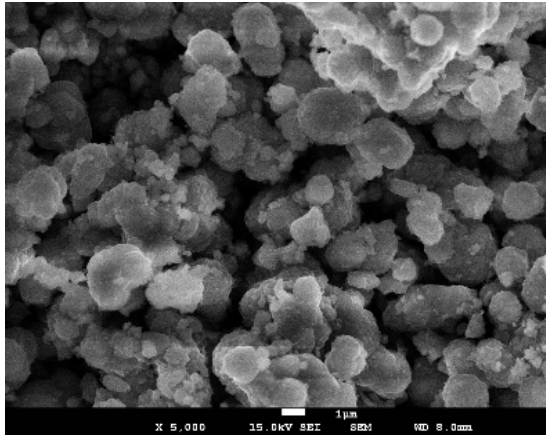
Figure 3. SEM micrographs of ( a ) Ni 0.35 Mn 0.65 CO 3 , ( b ) Ni 0.25 Mn 0.75 CO 3 , and ( c ) Ni 0.15 Mn 0.85 CO 3 powders, the results of the first step of the synthesis process.